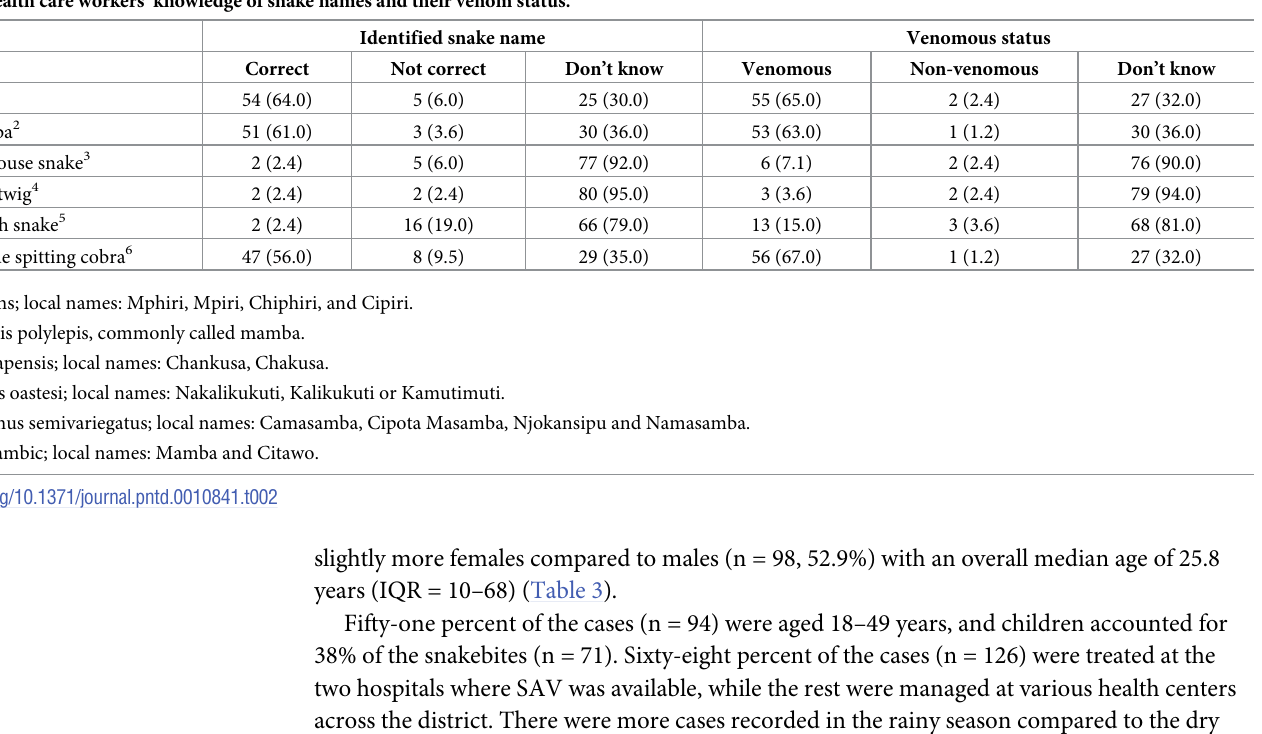
Table 2. Health care workers’ knowledge of snake names and their venom